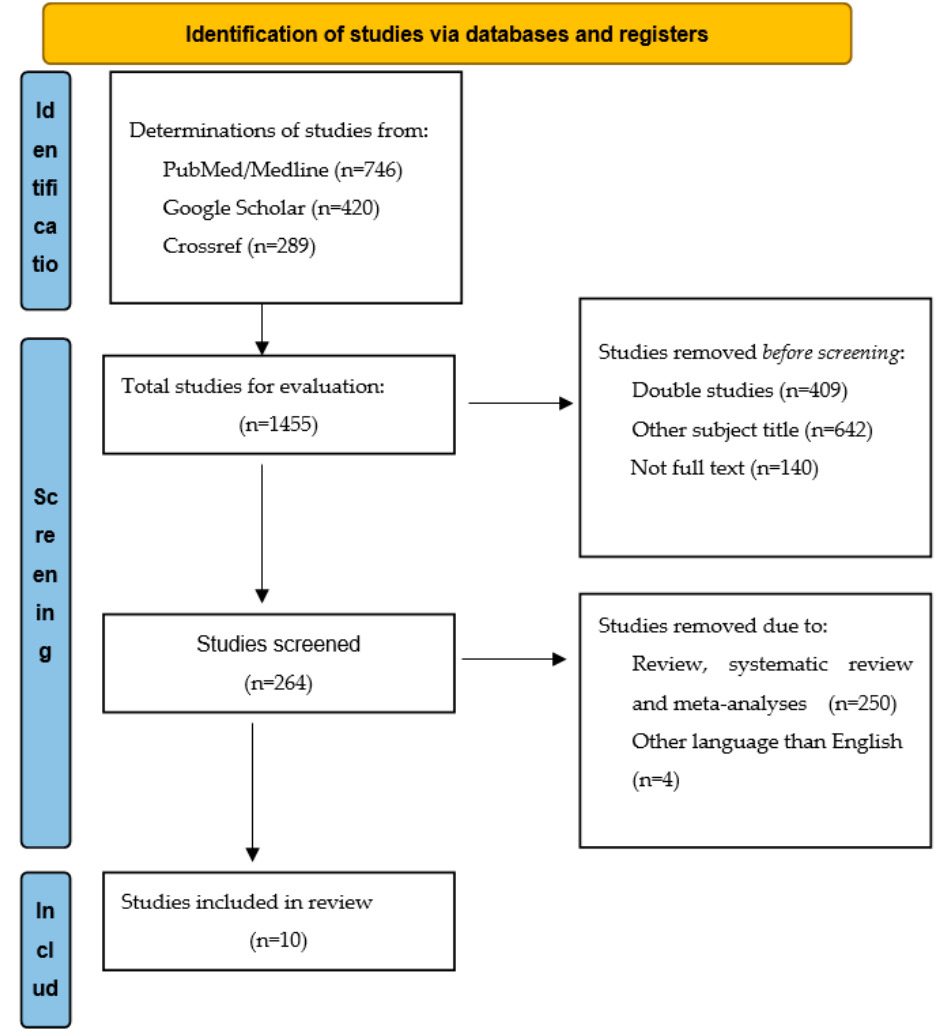
Figure 1. Flow diagram: structure search strategy.